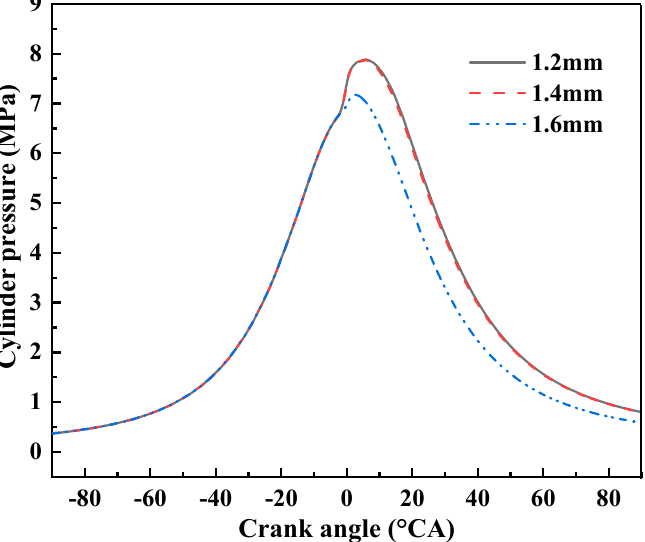
Figure 2. Comparison of the in-cylinder pressure curves of different basic grids.